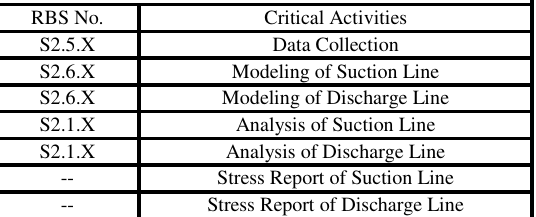
Fig. 2: Risk Priority Matrix Table 8: Critical Activities Related to the